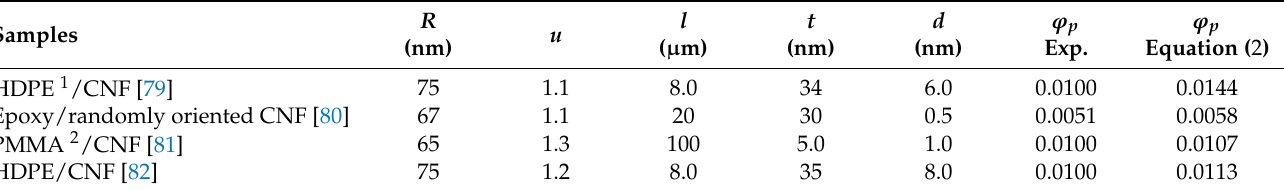
Table 1. Information of samples and theoretical and experimental values of percolation onset.